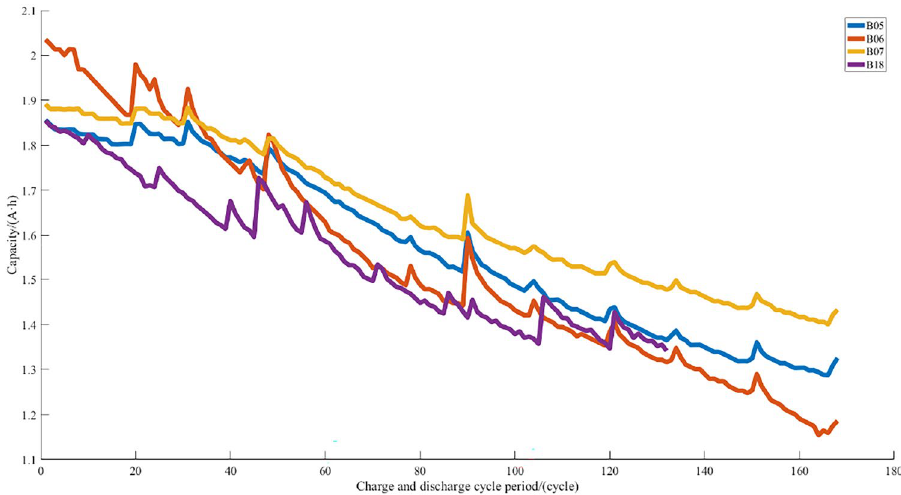
Figure 5. Chart of battery capacity